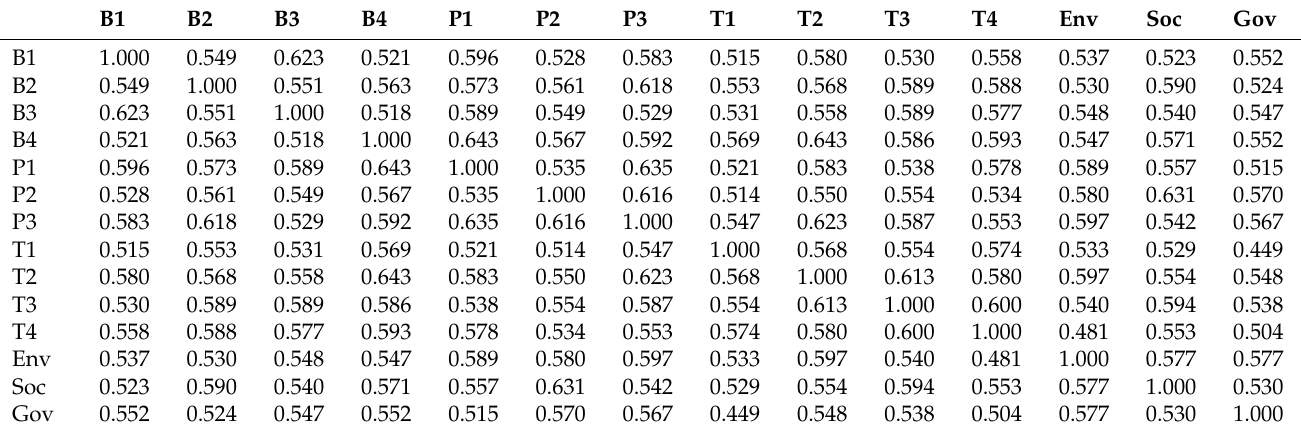
Table A3. The correlation matrix is a table showing the correlations between multiple